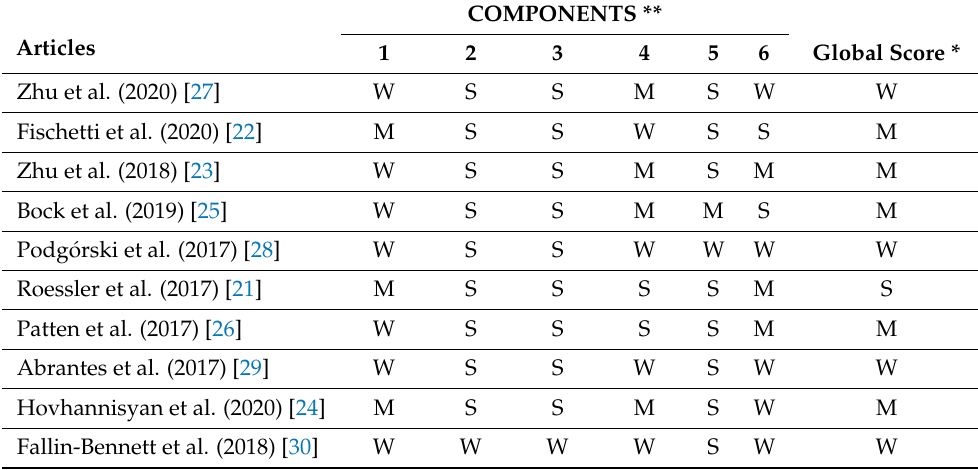
Table 1. Quality assessment components and ratings of the EPHPP instrument.